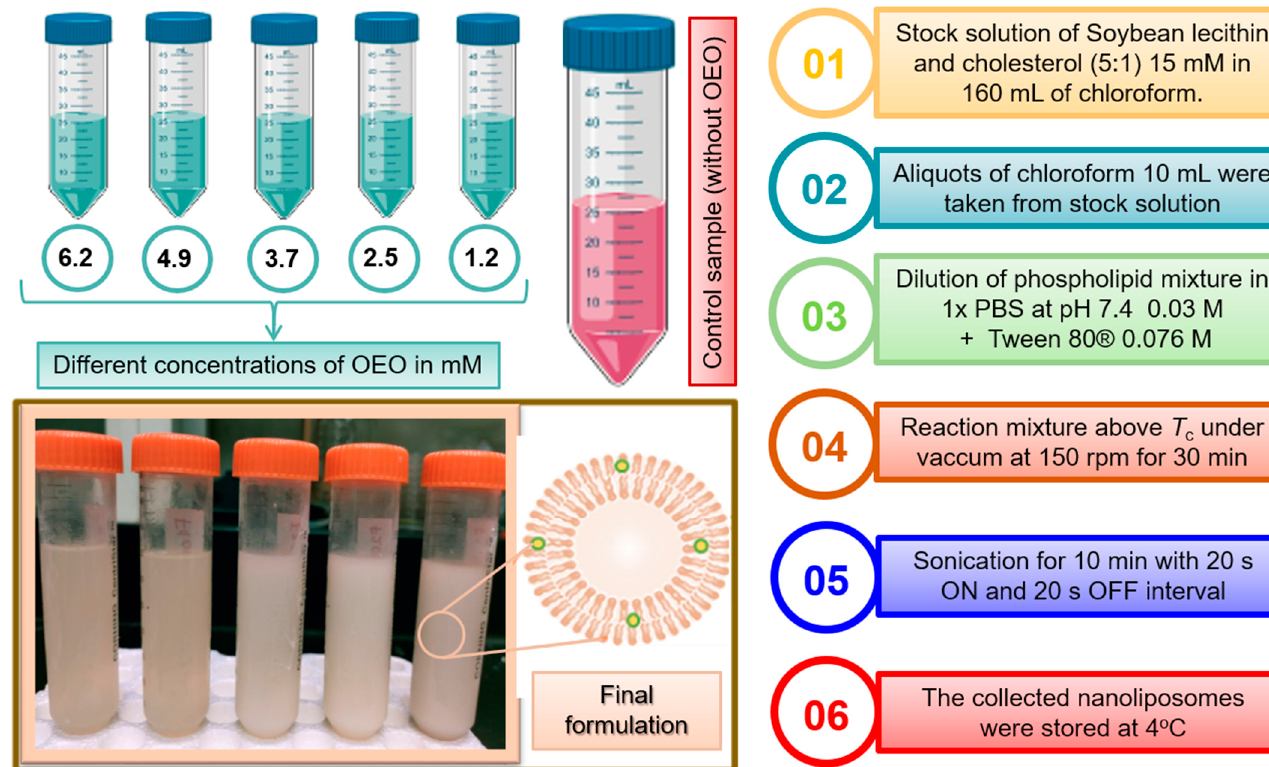
Figure 9. Schematic representation of OEO nanoliposome formulations at different concentrations (6.2, 4.9, 3.7, 2.5 and 1.2 mM) and empty nanoliposomes referred to as controls. Final milky solution at the bottom-left of the picture represents OEO nanoliposomes.